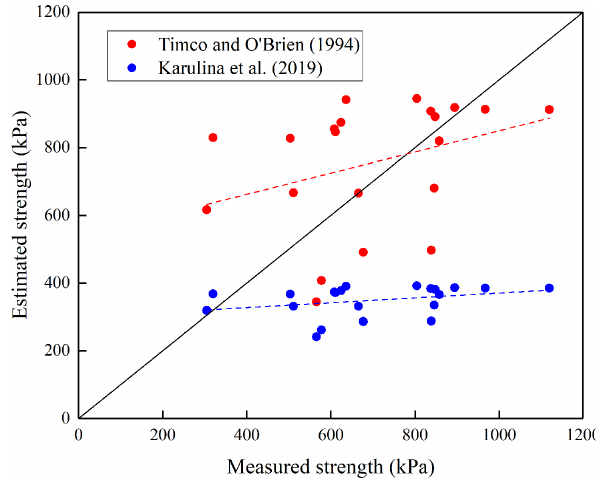
Figure 13. Comparisons between estimated flexural strength, us- ing previously established equations, and measured strength. The dashed lines are varying